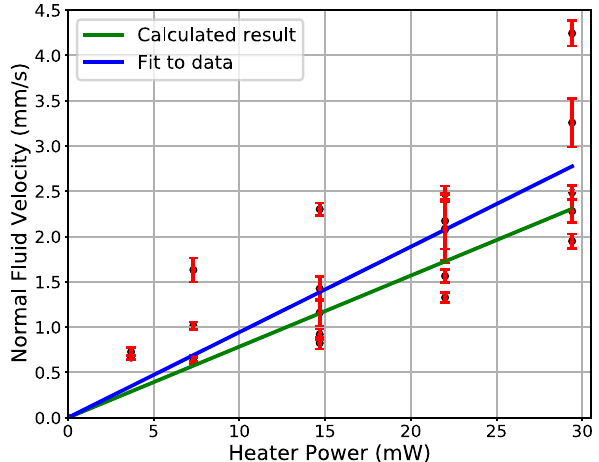
Figure 3. Mean velocity of fluorescence motion (aka fluid flow of the normal component) vs. heater power (Fig. 2). The error bars represent the uncertainty of the fitted velocities. The green line was obtained using Landau and Lifshitz’s equation for heat flux in He II, 44,45 and the blue line is the best weighted fit to the data with slope of 0.09(1)